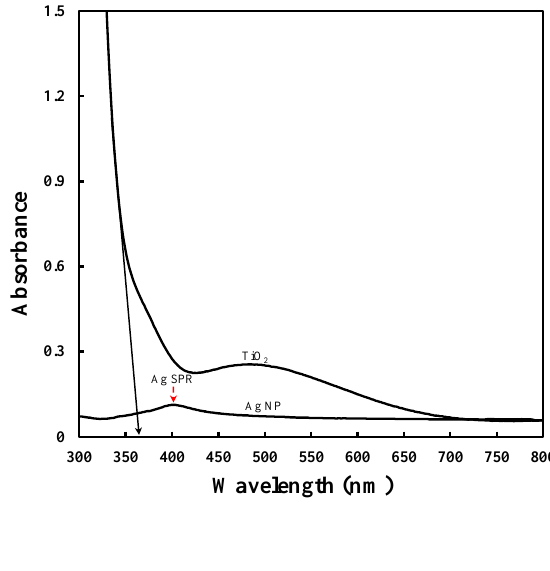
thin film and Ag NP fabricated on quartz 2